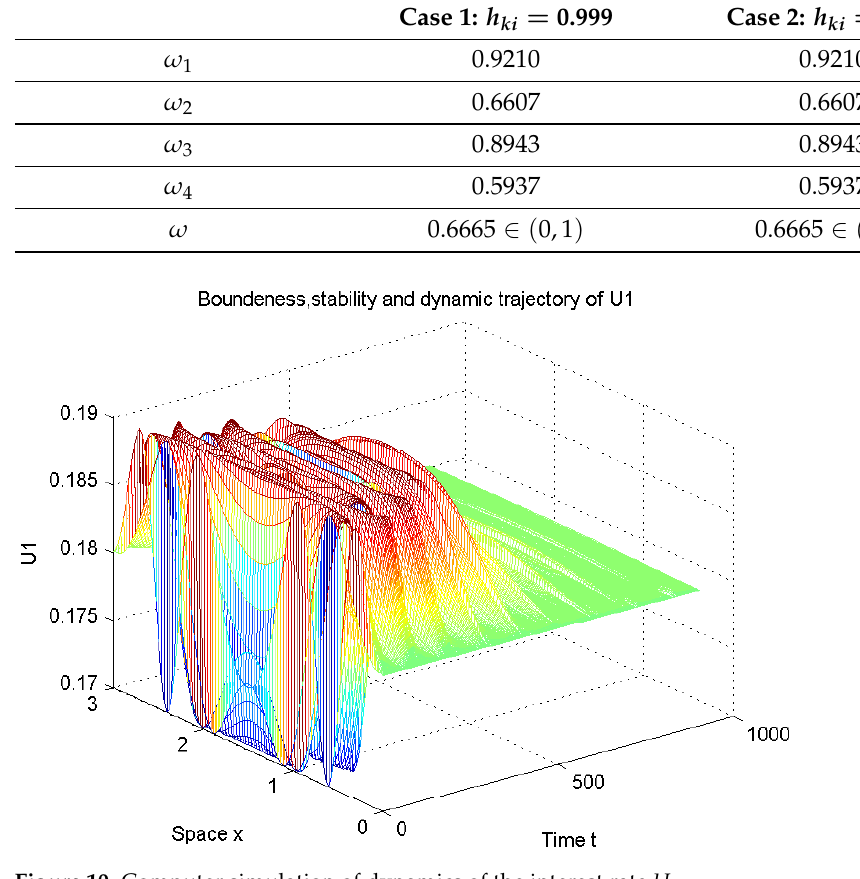
Figure 10. Computer simulation of dynamics of the interest rate U 1